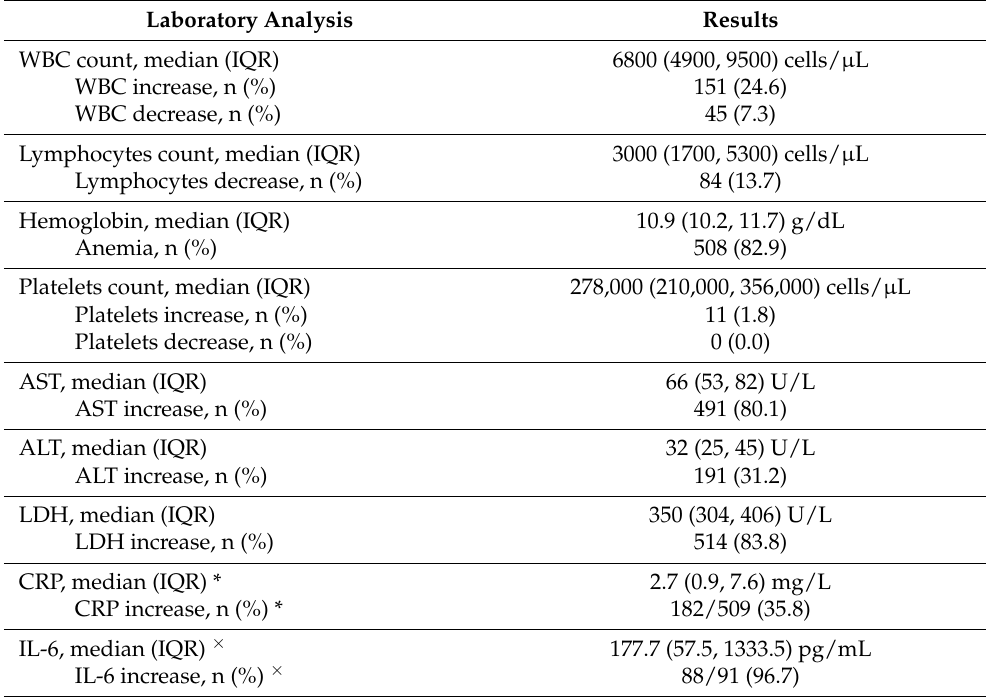
Table 2. Laboratory findings in infants included in the